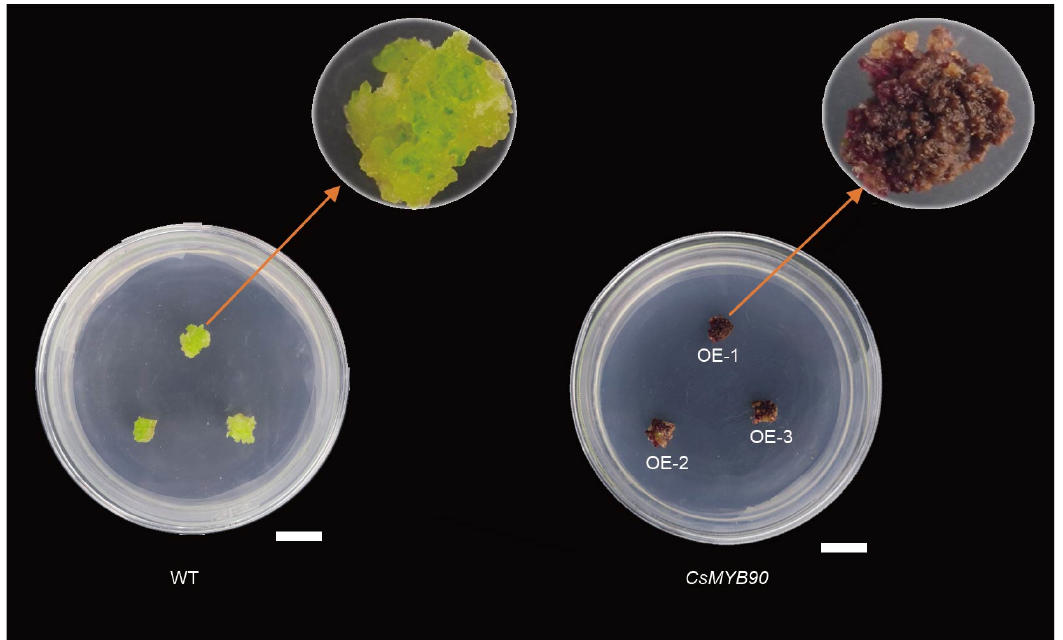
Figure 7. Overexpression of CsMYB90 resulted in visible dark-purple coloration in the calluses of transgenic tobacco. Bar = 1 cm.